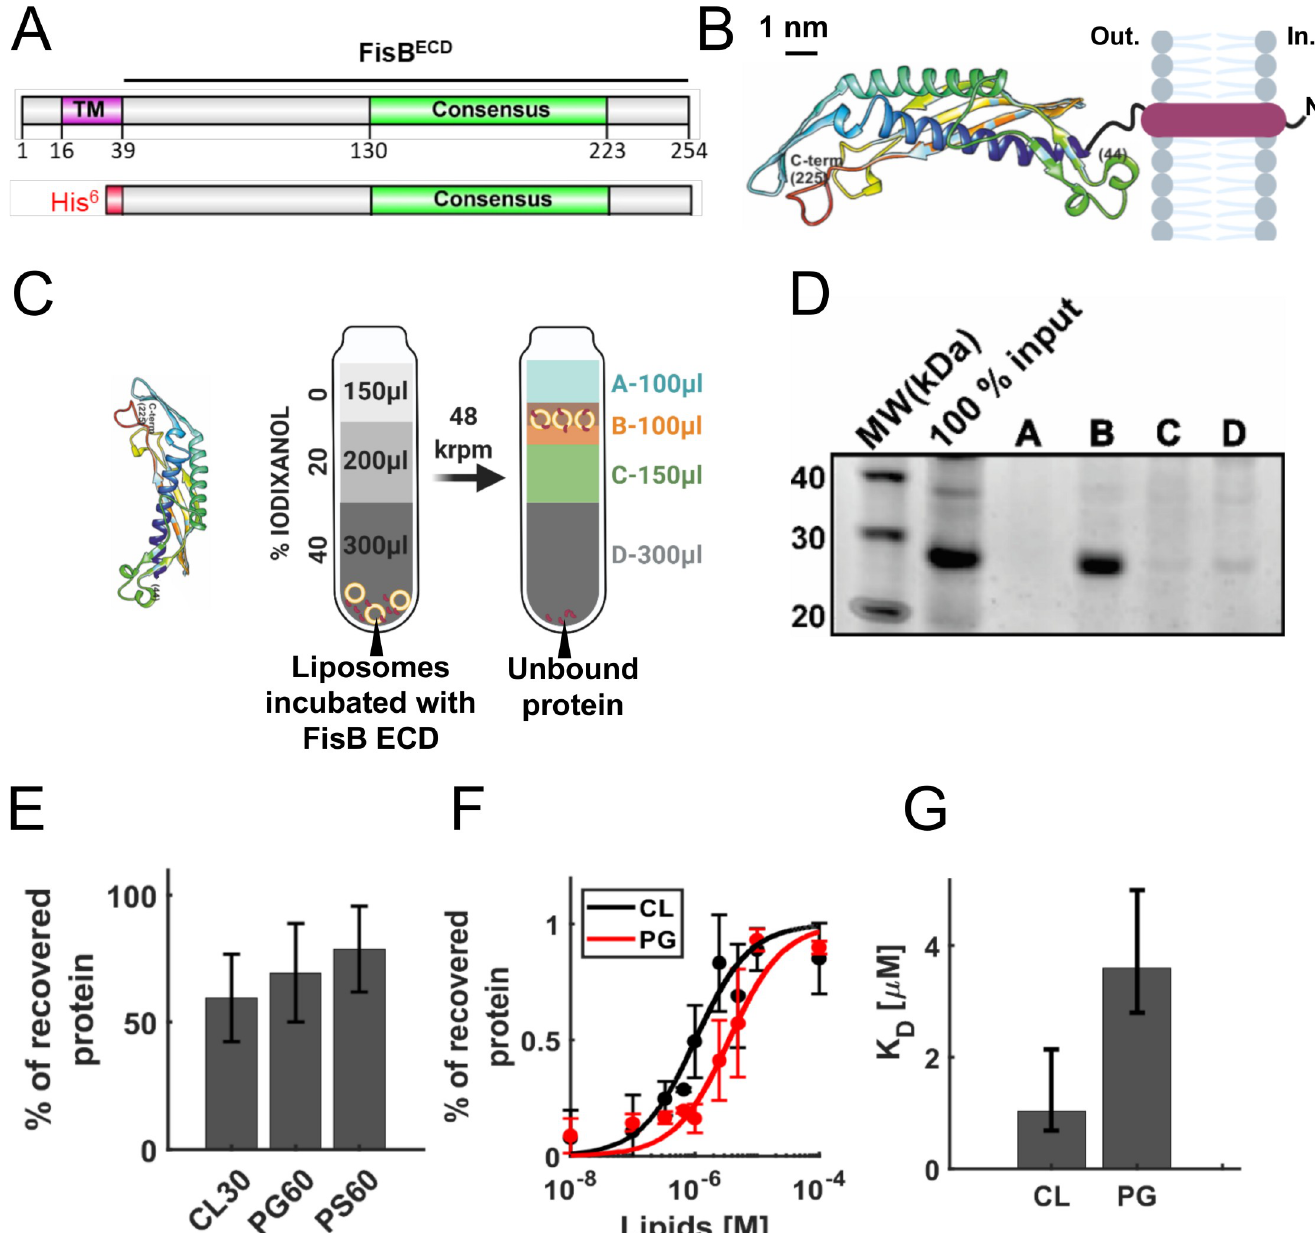
Fig 4. Binding of FisB ECD to acidic lipids. (A) Domain structure of FisB and its His 6 -tagged ECD used in floatation experiments. (B) Predicted model of FisB 44-225 comprising most of the ECD [49], schematically attached to the membrane. (C) Schematic of the floatation assay. Liposomes (40 nmol total lipid) and FisB ECD (200 pmol) were incubated for 1 hour (total volume of 100 μ l) at room temperature and layered at the bottom of an iodixanol density gradient. Upon ultracentrifugation, liposomes float to the top interface, whereas unbound protein remains at the bottom. Four fractions were collected as indicated and analyzed by SDS-PAGE. (D) SYPRO orange stained gel of FisB ECD incubated with liposomes containing 45 mole % CL. The percentage of recovered protein is determined by comparing the intensity of the band in fraction B to the input band intensity. (E) Indistinguishable amounts of FisB ECD are recovered when FisB ECD is incubated with liposomes containing different acidic lipid species as long as the charge density is similar. CL30, PG60, and PS60 indicate liposomes containing 30 mole % CL, 60 mole % PG, and 60 mole % PS, respectively. CL carries 2 negative charges, whereas PG and PS carry one each. The rest of the liposome composition is PC. (F) Fraction of liposome-bound iFluor555-FisB ECD (100 nM) recovered after floatation as a function of lipid concentration. Titration curves were fit to f b = K[L]/(1+K[L]), where f b is the bound fraction of protein, [L] is the total lipid concentration (assumed to be � [protein bound]) and K = 1/K d the apparent association constant, and K d is the apparent dissociation constant. (G) Best fit values for K d were 1.0 μ M for CL (95% confidence interval, CI = 0.7–2.1 μ M) and 3.6 μ M for PG (CI = 2.8–5.0 μ M), respectively. iFluor555-FisB ECD (100 nM) was incubated with10 − 8 to 10 − 4 M lipids for 1 hour at room temperature before flotation. Liposomes contained 45 mole % of CL or PG and 55% PC. CL, cardiolipin; ECD, extracytoplasmic domain; FisB, fission protein B; iFluor555-FisB ECD, iFluor555-labeled FisB ECD; PC, phosphatidylcholine; PG, phosphatidylglycerol; PS, phosphatidylserine.